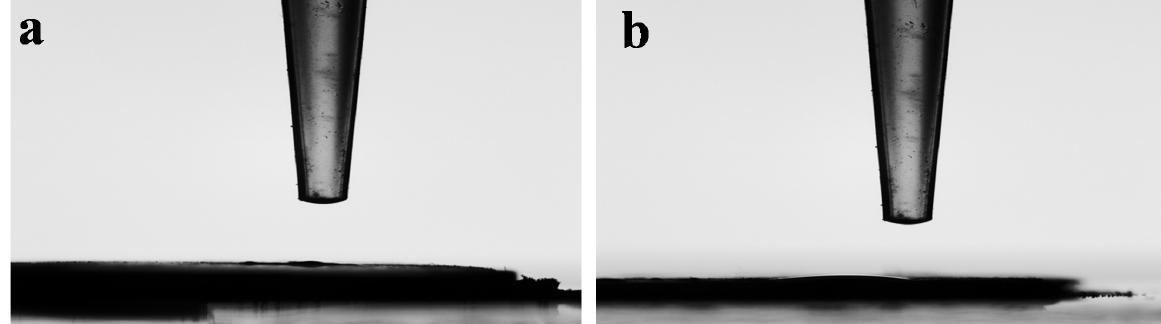
◦ and ( b ) CMAT 11.2 ◦ . Time